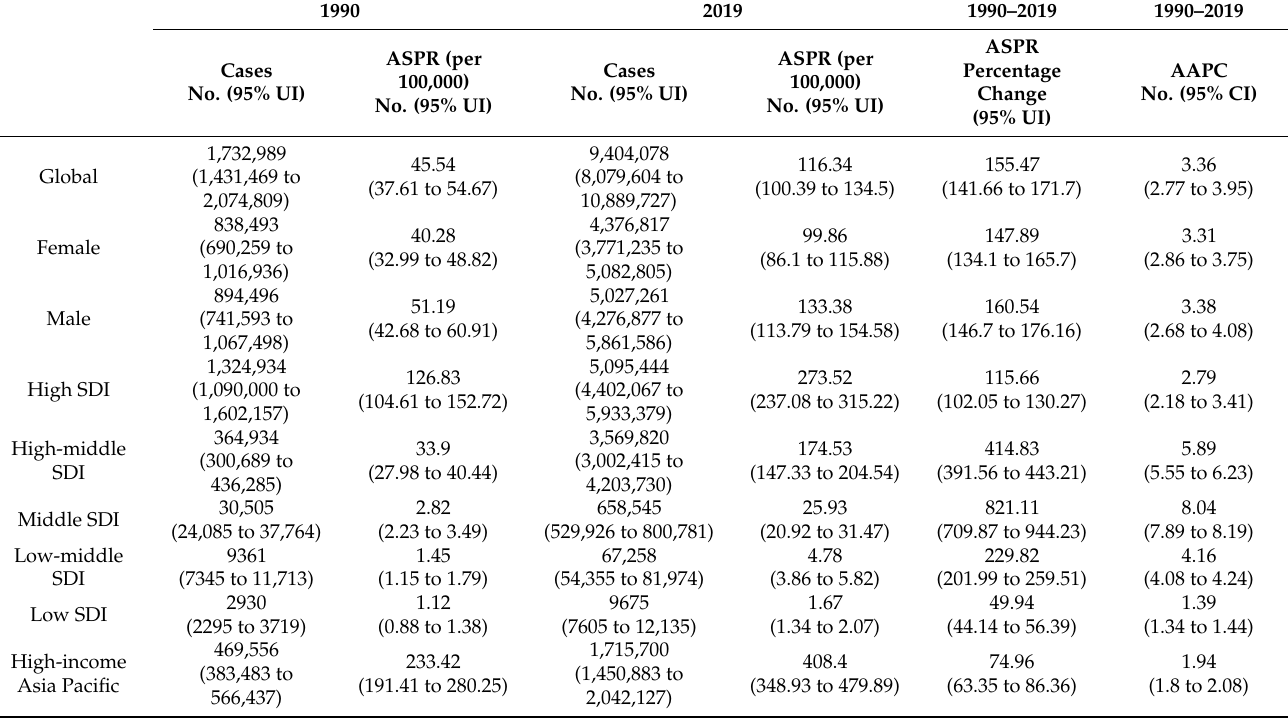
Table 1. The prevalence of cases and age-standardized prevalence rate of non-rheumatic calcific aortic valve disease in 1990 and 2019, and their temporal trends from 1990 to